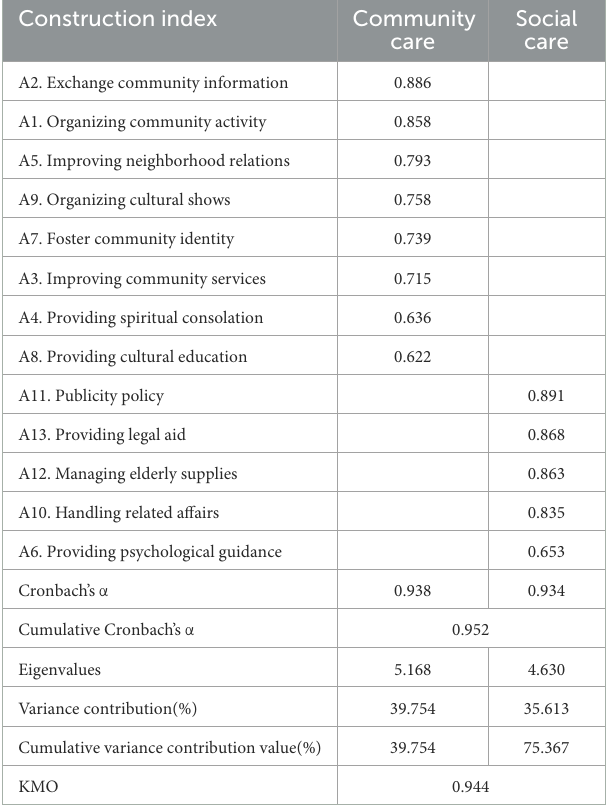
TABLE 2 Factor analysis result of “humanistic care”